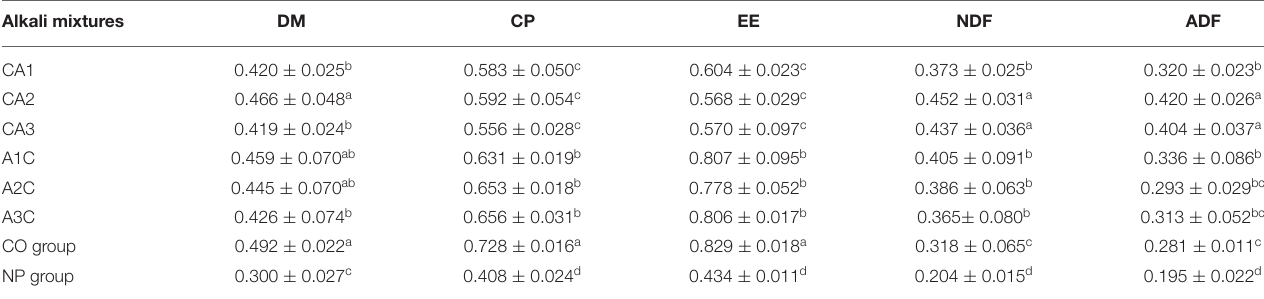
Alkali mixtures, refer to Table 1 alkali mixtures methods. DM, dry matter; CP: crude protein; EE, ether extract; NDF, neutral detergent fiber; ADF, acid detergent fiber. Values in the same column denoted by different superscript lowercase letters indicate significant differences (P < 0.05), whereas those denoted by the same letters (P > 0.05).